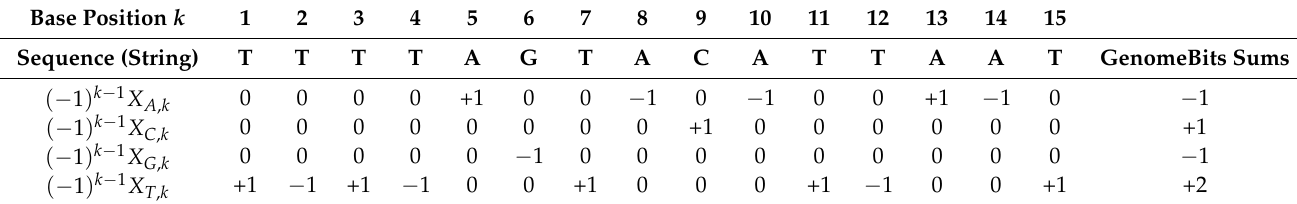
Letter sequence-to-numerical GenomeBits signal mapping. Single letters represent nucleotide codes: